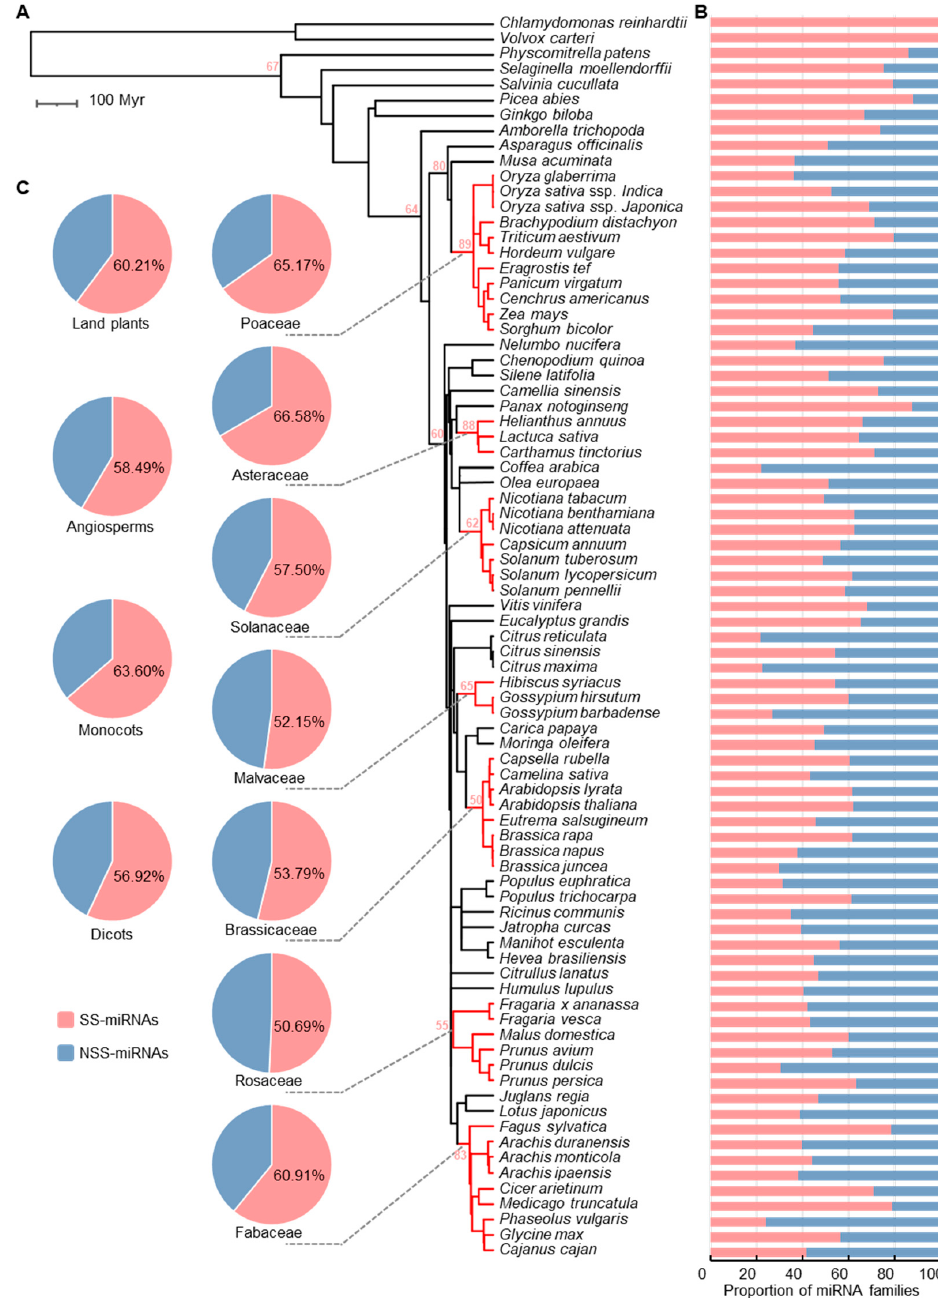
Figure 2. The panorama of SS-miRNA families in land plants. ( A ) A phylogenetic tree of 81 representative plant species retrieved from TimeTree.org. The mean numbers of SS-miRNA families in the taxonomic families are marked on the tree with red text. ( B ) Bar charts showing the proportions of SS-miRNA families and NSS-miRNA families in 81 species. ( C ) Pie charts showing the proportions of SS-miRNA families and NSS-miRNA families in land plants, angiosperms, monocots, dicots, and seven representative families.